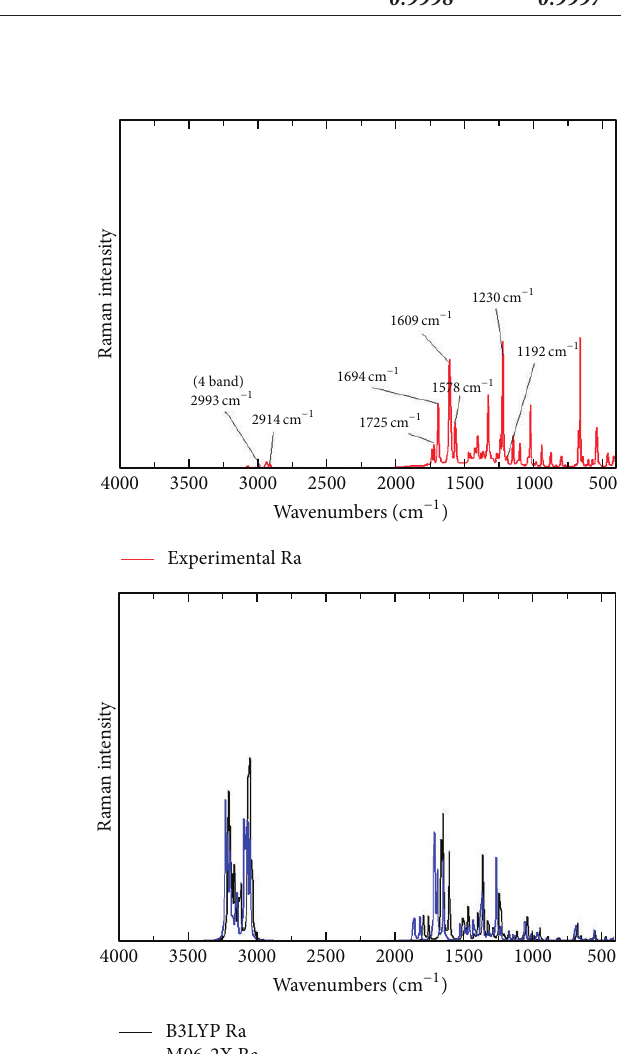
Figure 2: Comparison of observed and calculated infrared spectra of compound 2 .